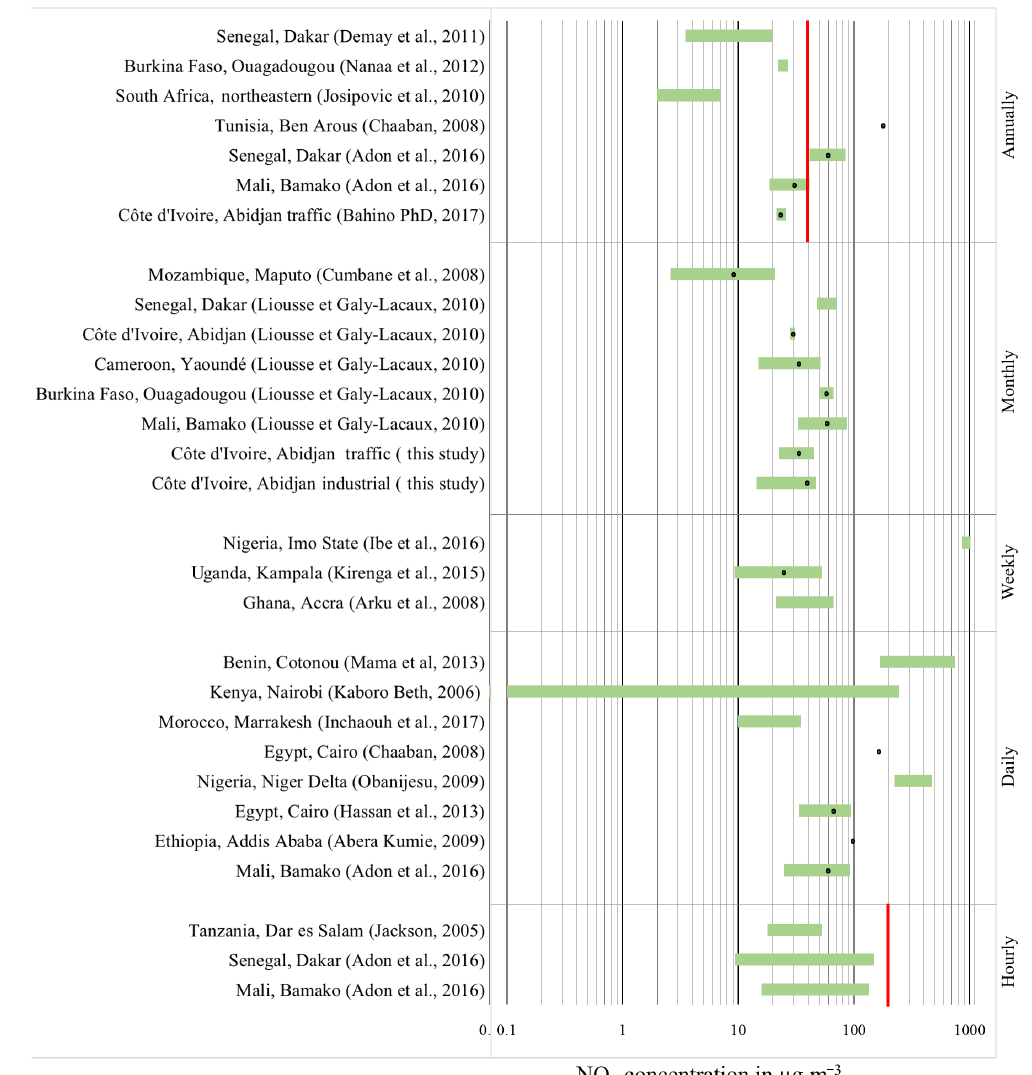
Figure 14. NO 2 concentration levels in µgm − 3 in African capitals at different timescales (hourly, daily, weekly, monthly and annually) as reported in literature. Green bars represent lower and upper range of means if reported. Black points represent average concentration of NO 2 . Red vertical lines illustrate current WHO guidelines at different